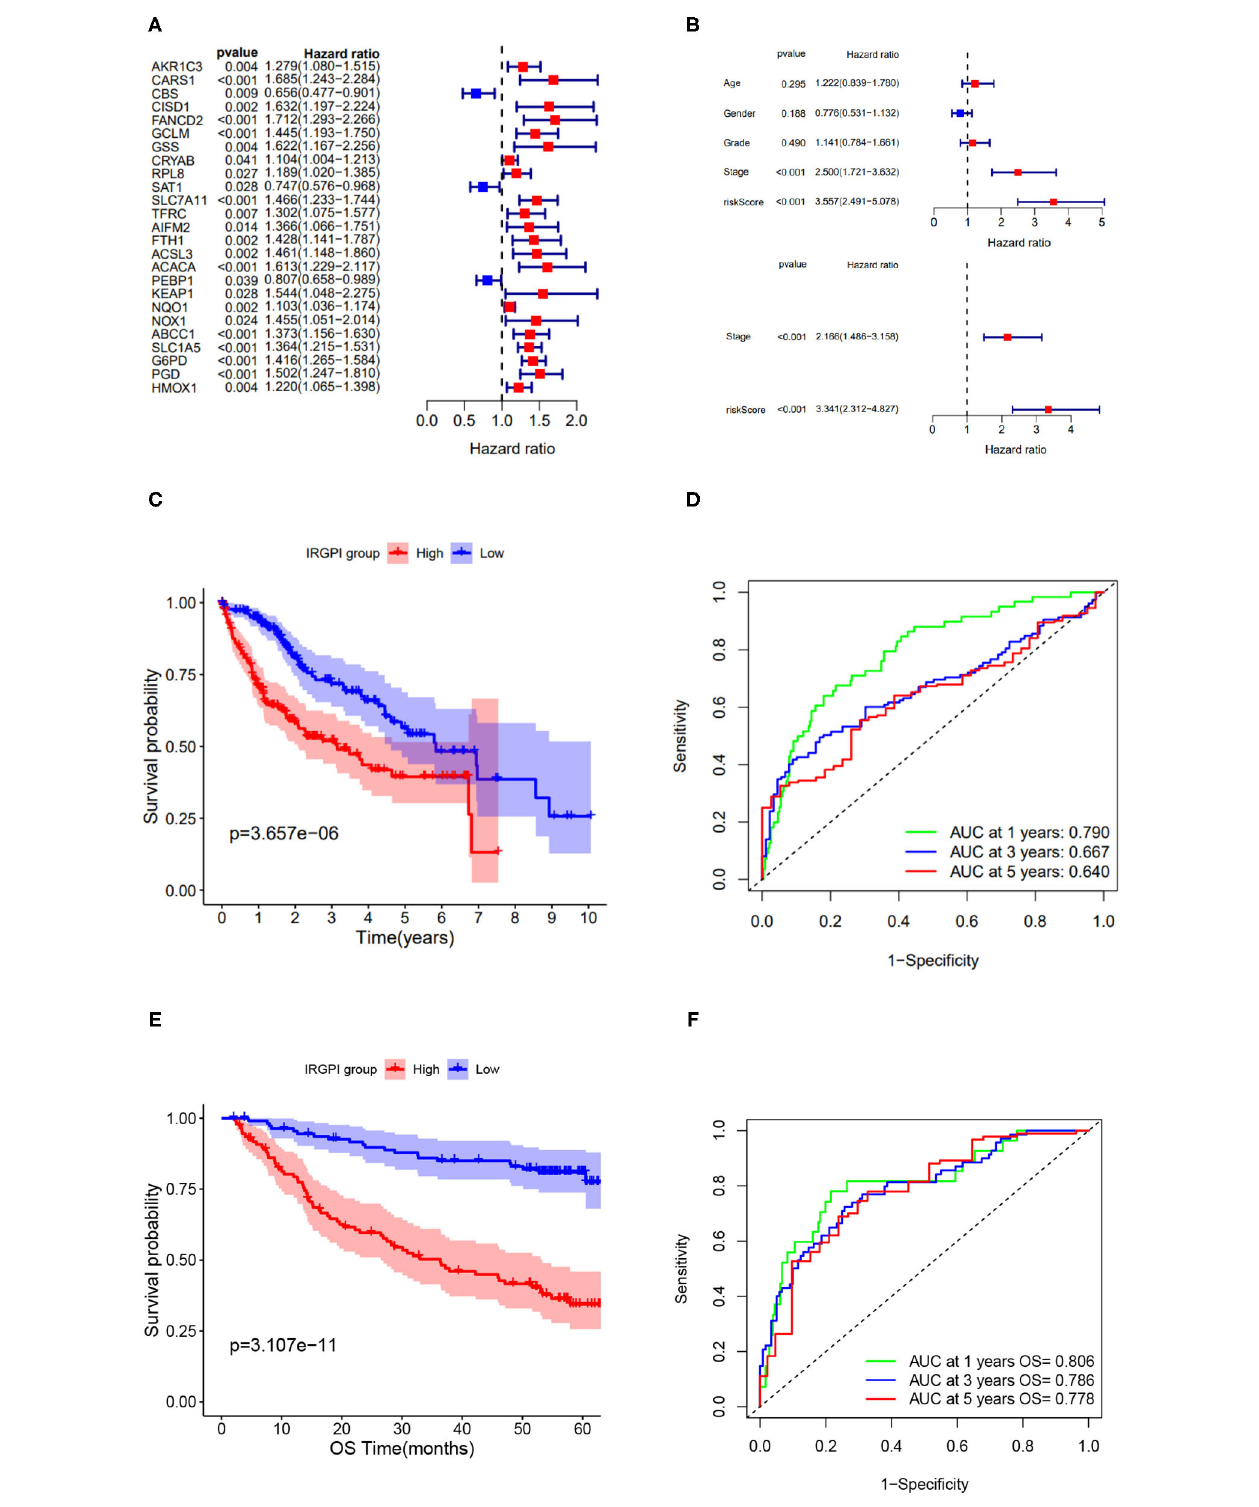
FIGURE 3 | Screening of immune-related prognostic genes via Cox and LASSO regression and survival analysis of IRGPI low- and high-risk groups. (A) Univariate Cox regression of 25 immune-related hub genes. (B) Univariate and multivariate Cox regression analysis on IRGPI and other clinicopathologic variables.